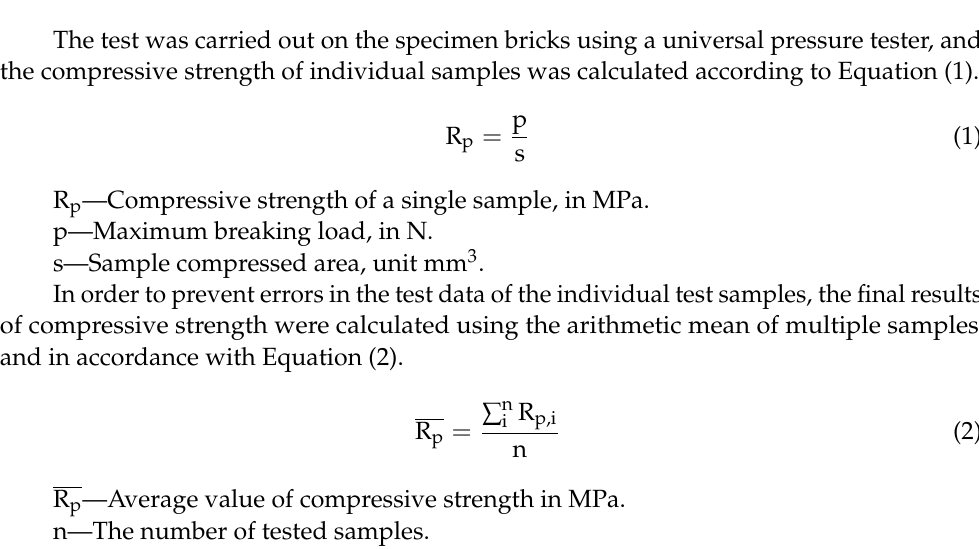
Figure 2. Preparation of compressive strength samples.